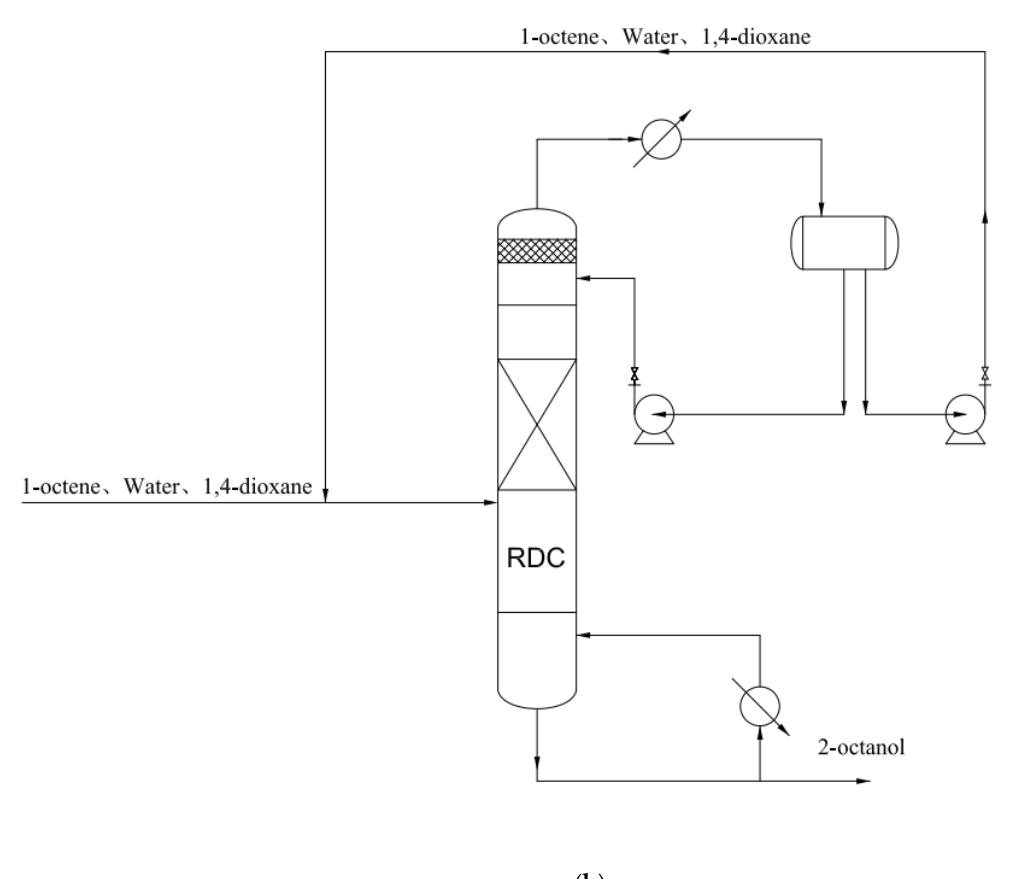
Figure 11. Preliminary design of the process for producing 2-octanol by reactive distillation. ( a ): the first conceptual design; ( b ): the second conceptual